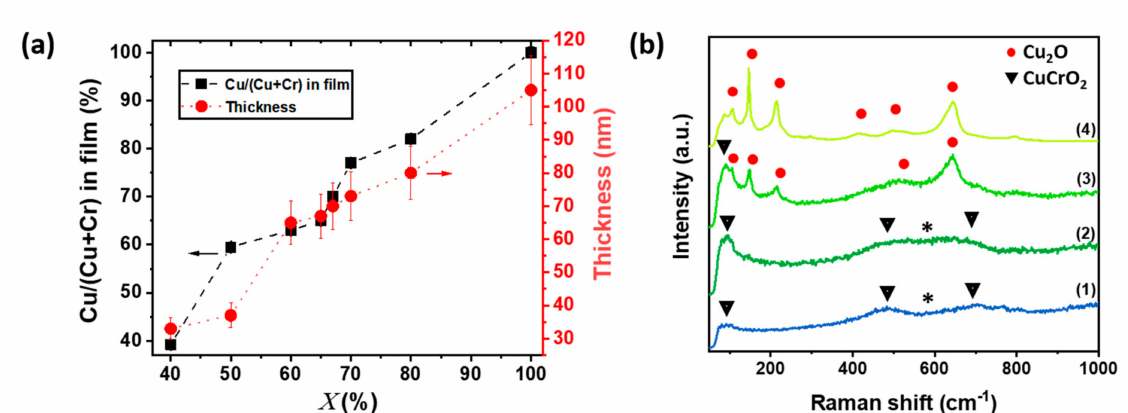
Figure 1. Cationic ratio, thickness, and structural properties of out of stoichiometry CuCrO 2 thin films. ( a ) Variation as a function of cationic ration in solution, X , of the cationic ratio Cu/(Cu + Cr) in the film (left axis, black squares connected by dashed line) measured by EDX and the thickness of the films measured by SEM cross-section observation (right axis, red circles connected by dotted line). ( b ) Raman spectra for samples deposited using a X value of (1) 40%, (2) 65%, (3) 67%, and (4)